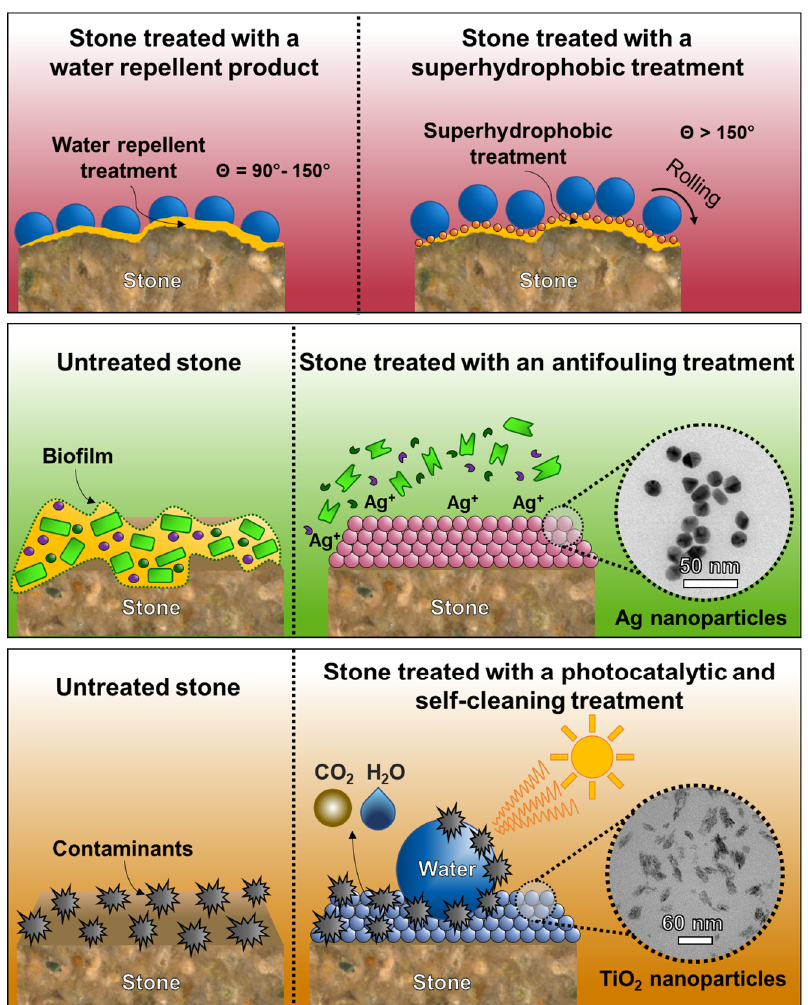
Figure 3. Top row: static contact angle ( Θ ) of a water drop on a stone surface treated with a water repellent product and with a superhydrophobic treatment. Middle row: schematic representation of biofilm deposition on untreated stone surfaces and the antifouling properties of surfaces treated with silver (Ag) nanoparticles, and Transmission Electron Microscopy (TEM) image of the nanoparticles. Bottom row: schematic representation of contamination of stone surfaces by pollutants and the photocatalytic and self ‐ cleaning properties of surfaces treated with TiO 2 nanoparticles, and TEM image of the